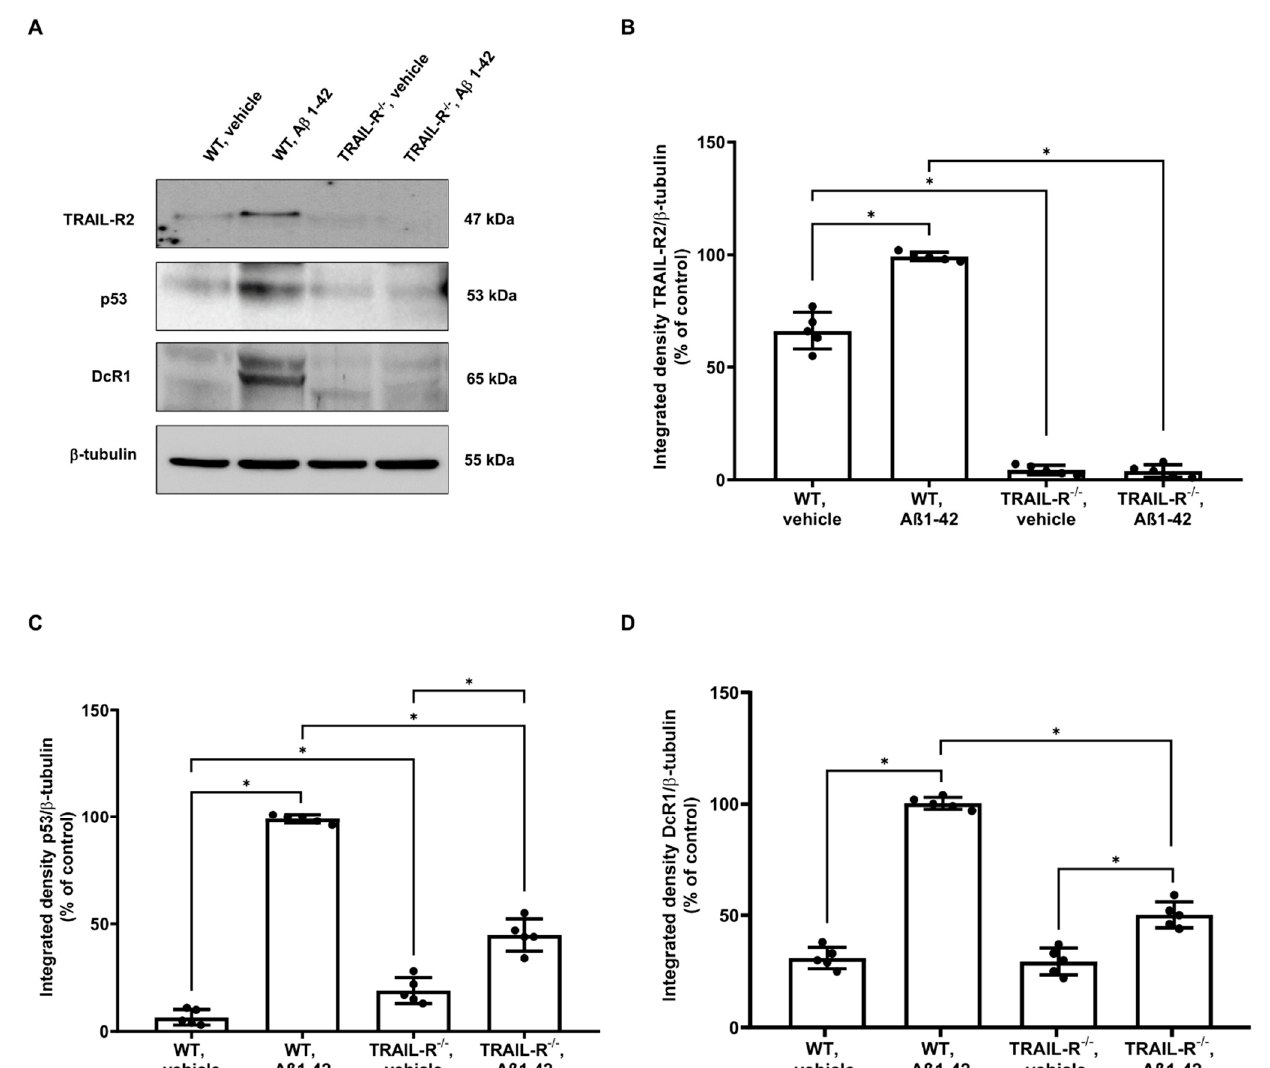
Figure 3. TRAIL-R2 is essential for p53 to mediate A β -related neurotoxicity. ( A ) Western blot for TRAIL-R2, p53, and DcR1 protein expression in the hippocampus of WT and TRAIL-R − / − mice following stereotaxic infusion of oligomeric A β 1-42 or vehicle. ( B ) Densitometric analysis of TRAIL- R2, ( C ) p53 and ( D ) DcR1 western blots. Data are expressed as means ± SEM. One-way ANOVA and the Bonferroni post-hoc test were used to determine statistical significance. * p < 0.05. N = 5 animals for each group.